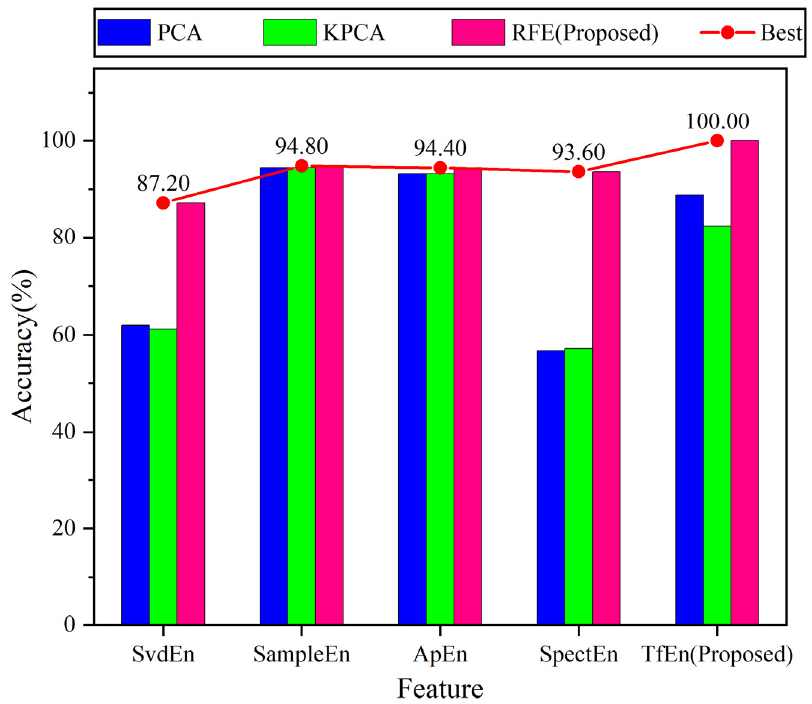
Figure 11. Comparisons with 4 mainstream entropy-based feature extraction methods.